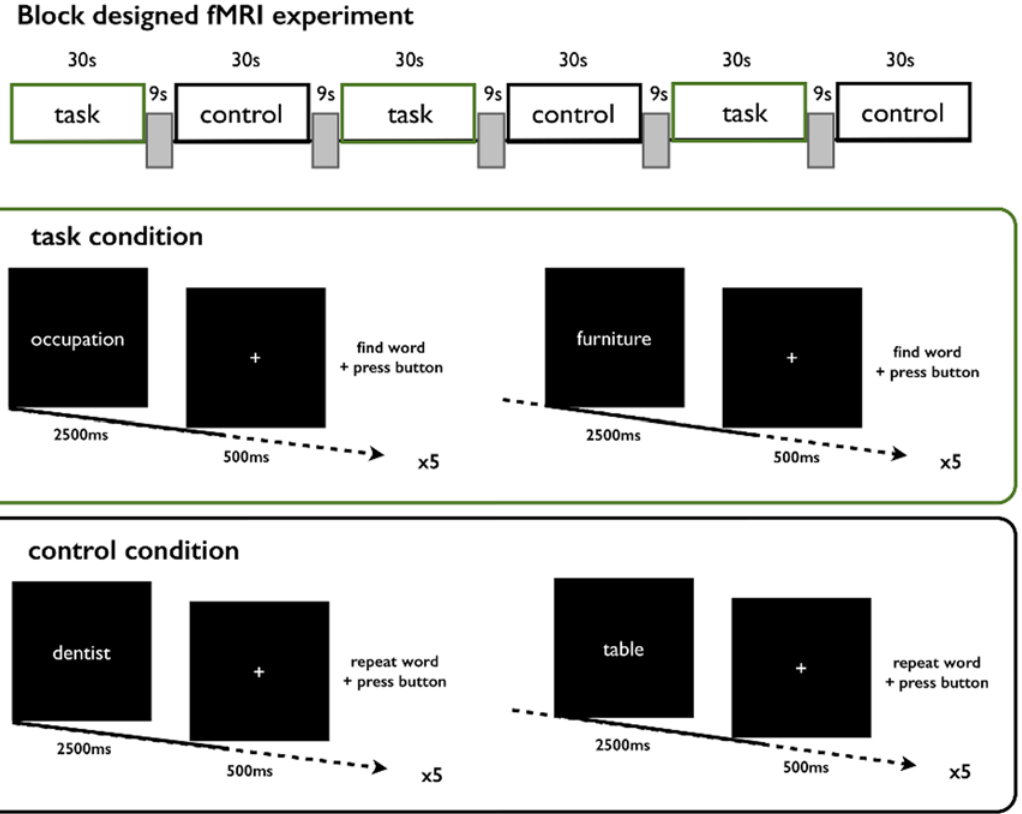
Fig 1. fMRI Semantic Verbal Fluency Task. The experiment consisted of three task and three control blocks. In the task condition, subjects were presented with a categorical word (semantic task) or syllable of the Japanese alphabet (phonological task) for 2500ms (e.g. occupation) for which they had to find a matching word, utter it in their minds and press a button. A white cross displayed for 500ms indicated the end of the trial. This was repeated five times each for two words referring to two different categories in the semantic task and two different syllables in the phonological task. In the control condition, the button press occurred after repeating the displayed word in the mind. Two different words were displayed five times each. The end of each block was indicated by 9 seconds of blank screen.